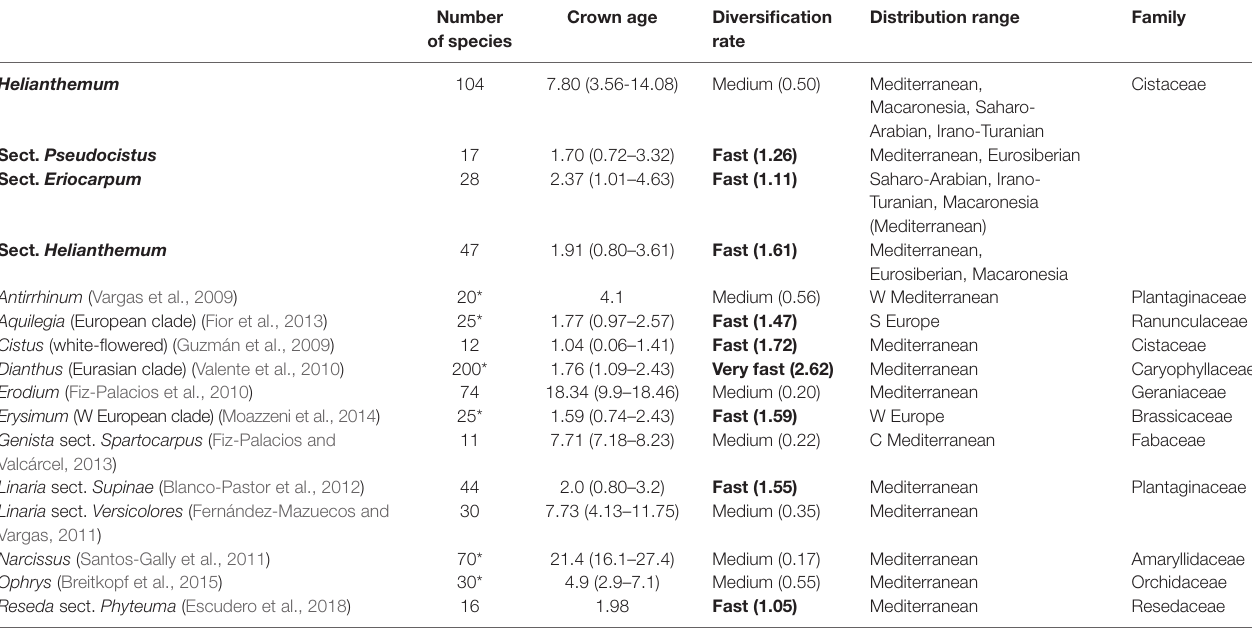
TaBlE 4 | Diversification rates of several species-rich plant clades from the Mediterranean Basin, including the genus Helianthemum and its three largest sections Eriocarpum , Pseudocistus, and Helianthemum